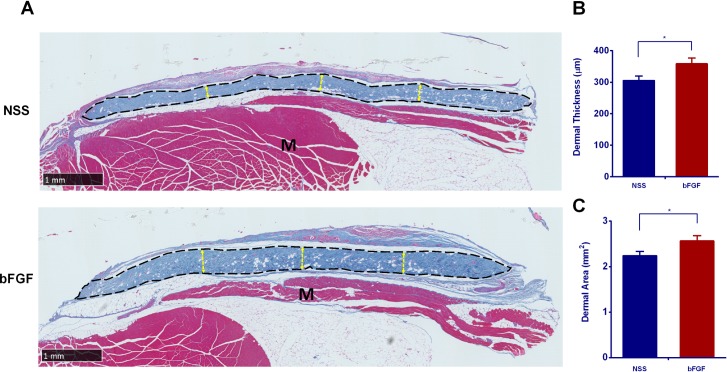
The assessment of dermal thickness and area after 8 weeks implantation.(A) A micrograph of the Azan staining at Week 8. The areas of the grafts are indicated by broken black lines. No signs of infection or necrosis were observed in either group. The yellow broken line indicates the evaluated thickness of the grafts, M: recipients’ muscle; Magnification: 2x, scale bar: 1 mm. (B) A comparison of the thickness of the grafts between the two groups at Week 8. The grafts in the bFGF group were significantly thicker than those in the NSS group (* p < 0.05). (C) A comparison of the area of the grafts between the two groups at Week 8. The dermis of the bFGF group was significantly larger than that in the NSS group (* p < 0.05).